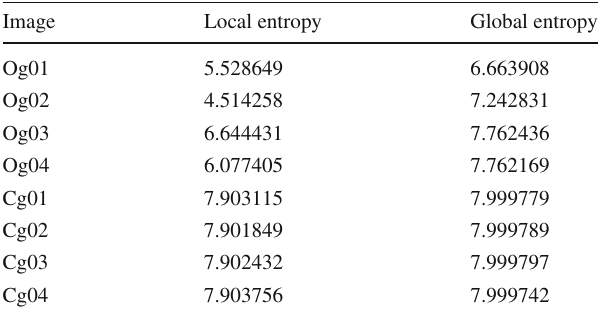
Table 4 Results of local and global entropy values for the examined images Image